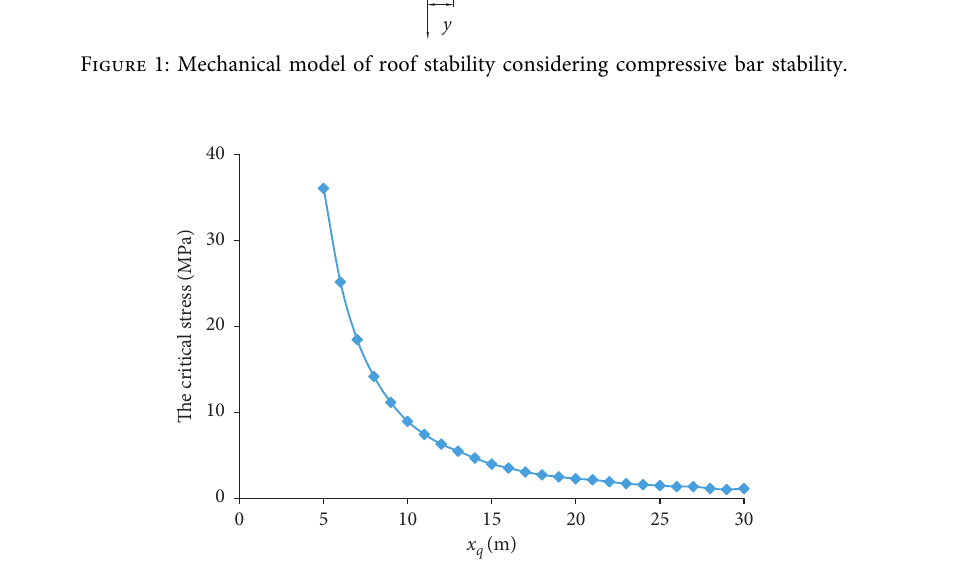
Figure 2: The relationship between critical horizontal stress and x